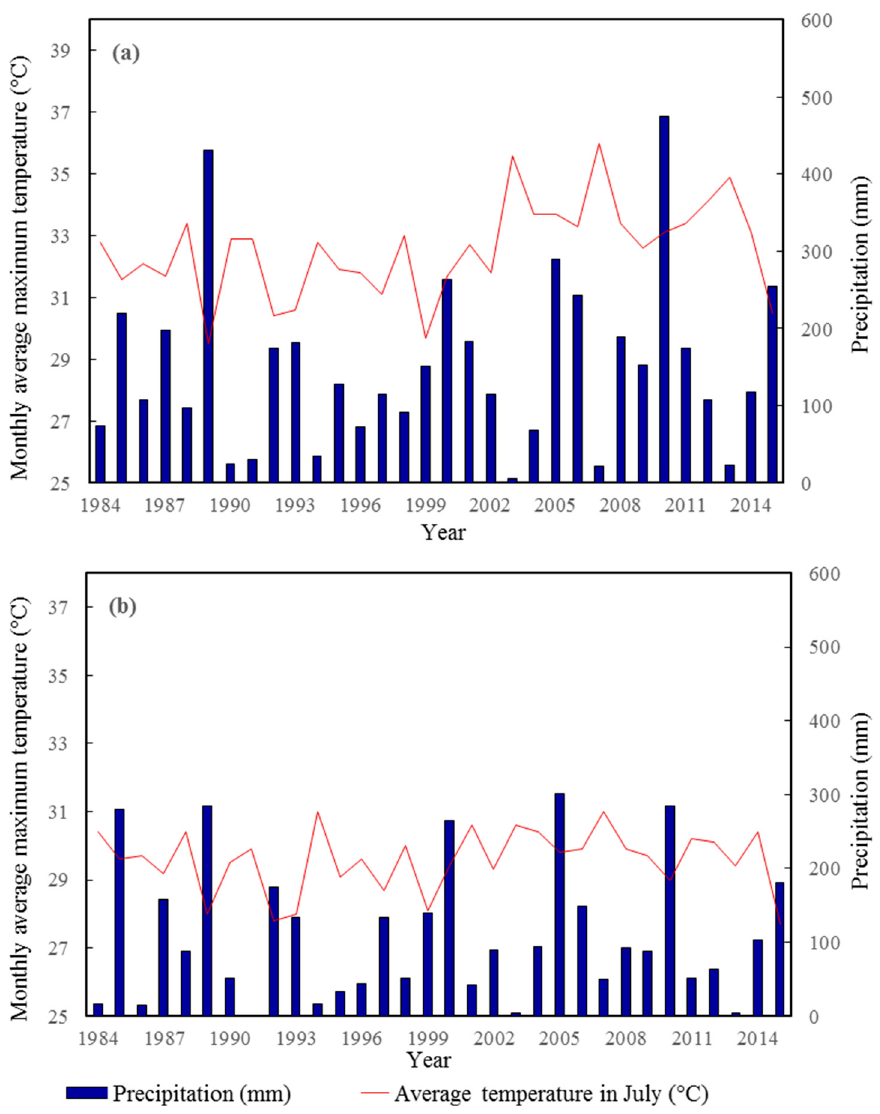
Figure 4. Precipitation and monthly average maximum temperatures in July in Taizhou ( a ) and Yuhuan ( b ) showing the most drought events in 1991, 2003 and 2013.